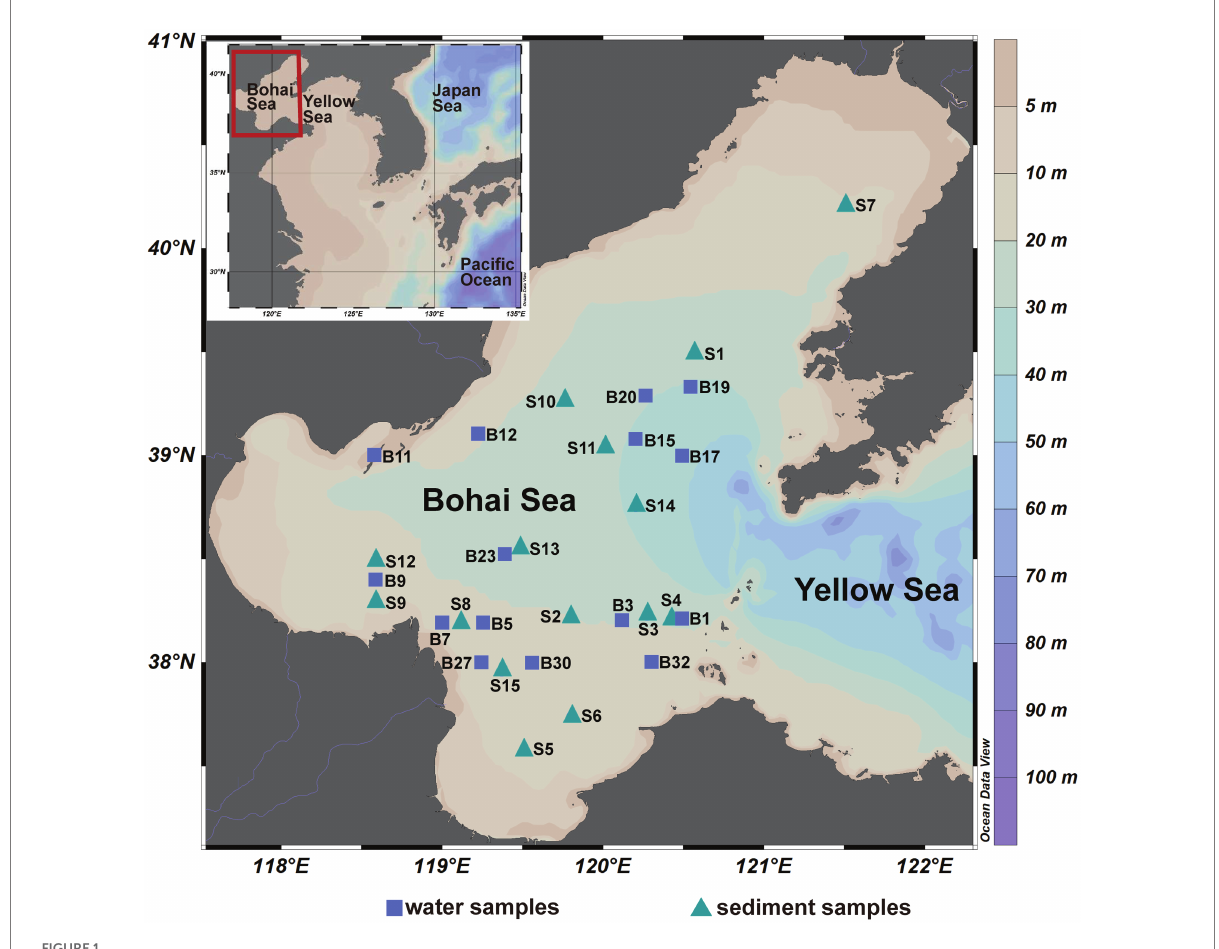
FIGURE 1 The sampling sites of the Bohai Sea,